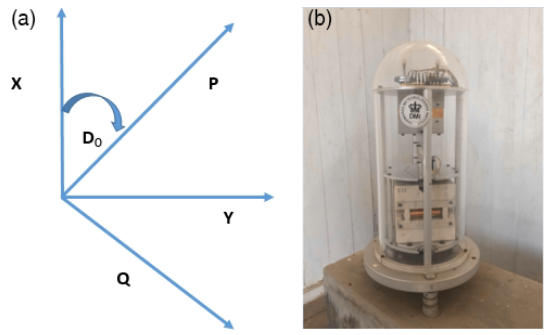
Figure 3. Sensor orientation (a) of a typical fluxgate magnetome- ter (b) in the horizontal plane. P and Q define the orthogonal sen- sors aligned in the horizontal plane, D o is the declination, and X and Y are geographic north and